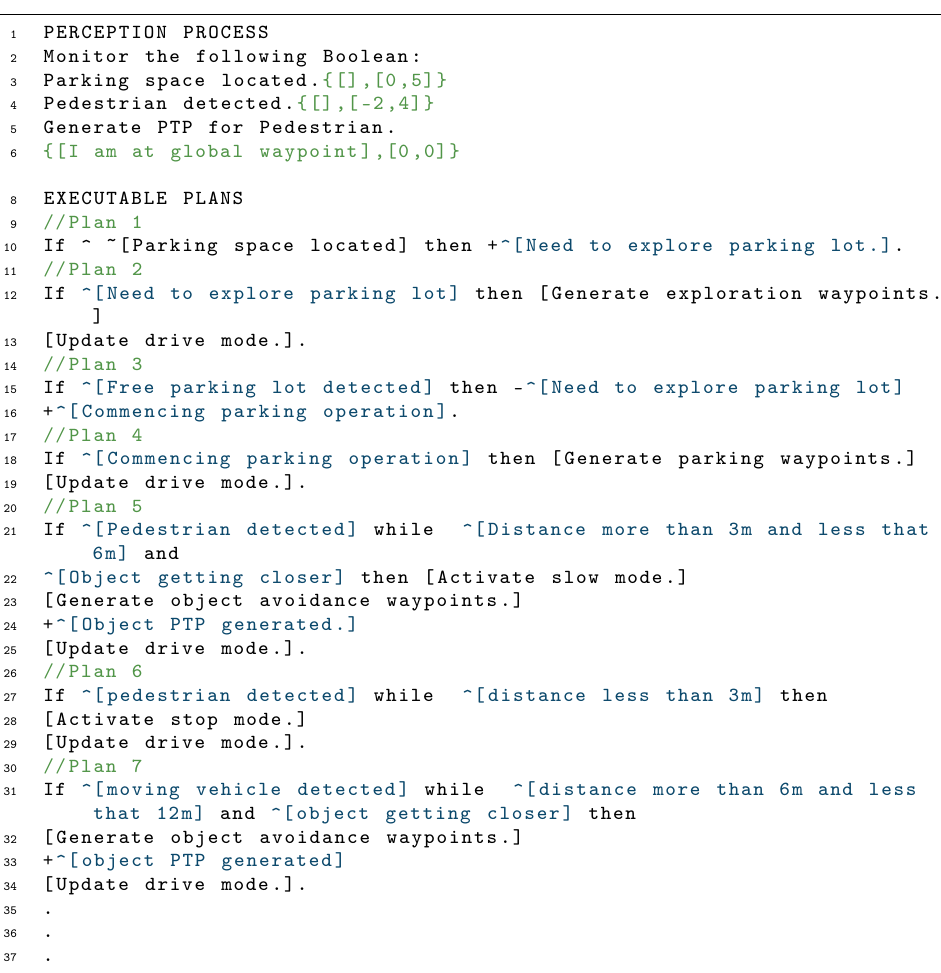
Figure 8. Part of the agent code used to control the